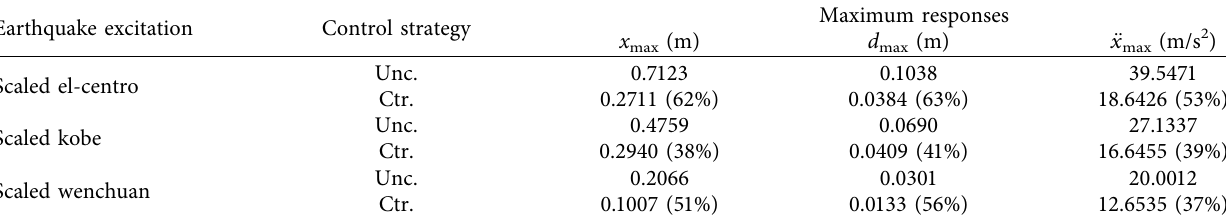
Unc indicates without control; Ctr indicates the proposed control.